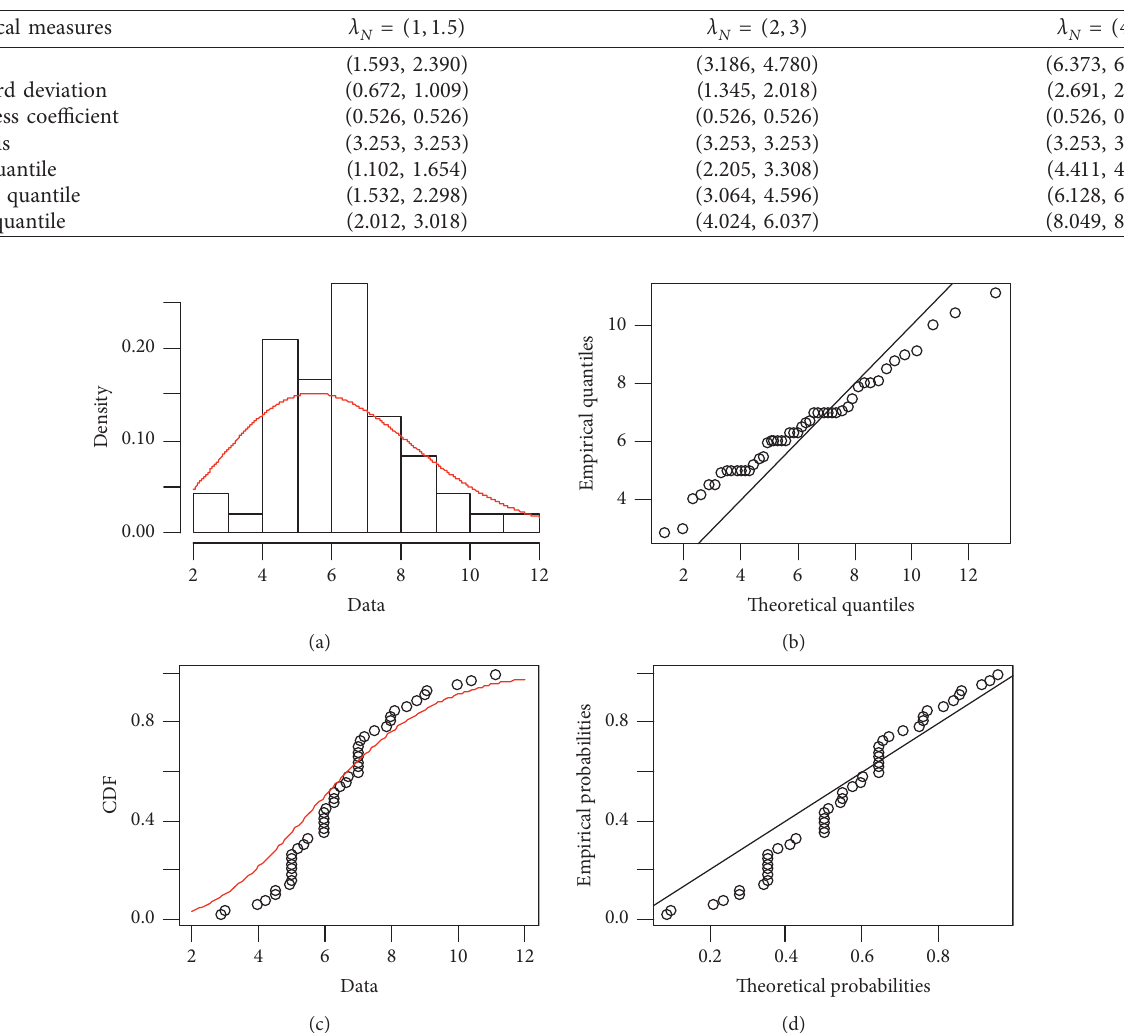
Figure 3: Fitting of NMD on incubation period data. (a) Empirical and theoretical dens. (b) Q-Q plot. (c) Empirical and theoretical CDFs. (d) P-P